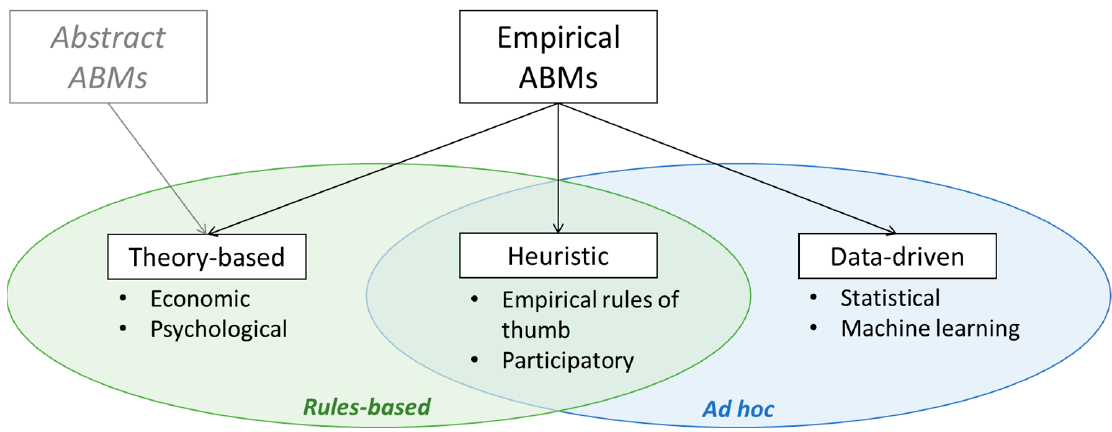
Figure 1. Approaches to design agents’ behaviours in agent-based models (ABMs).